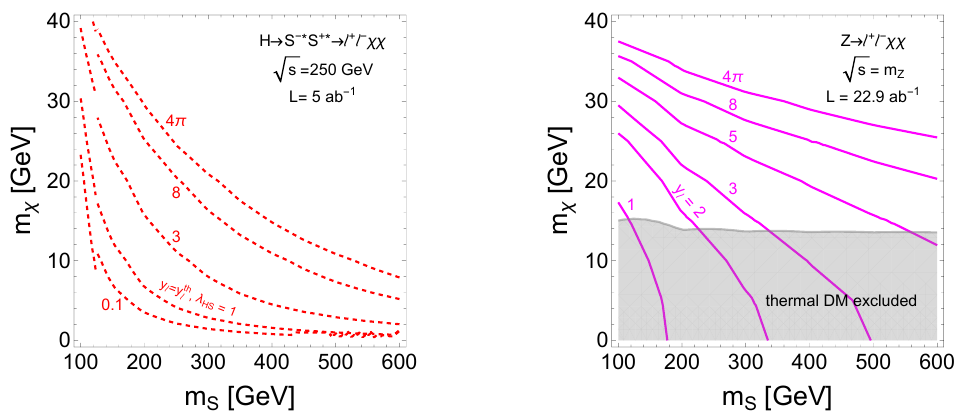
Figure 5 . Left: the 95% C.L. constraint on the coupling combination λ HS as contours from the exotic decay h → S ± ( ∗ ) S ∓∗ → ‘ + χ‘ 0− χ . The lepton portal coupling y the value to provide the correct DM relic abundance. Right: the 95% C.L. constraint contours (magenta) for y for the exotic decay Z → ‘ + χ‘ 0− χ . The gray shaded region shows the parameter ‘ space can be excluded if y = y th ‘ ‘